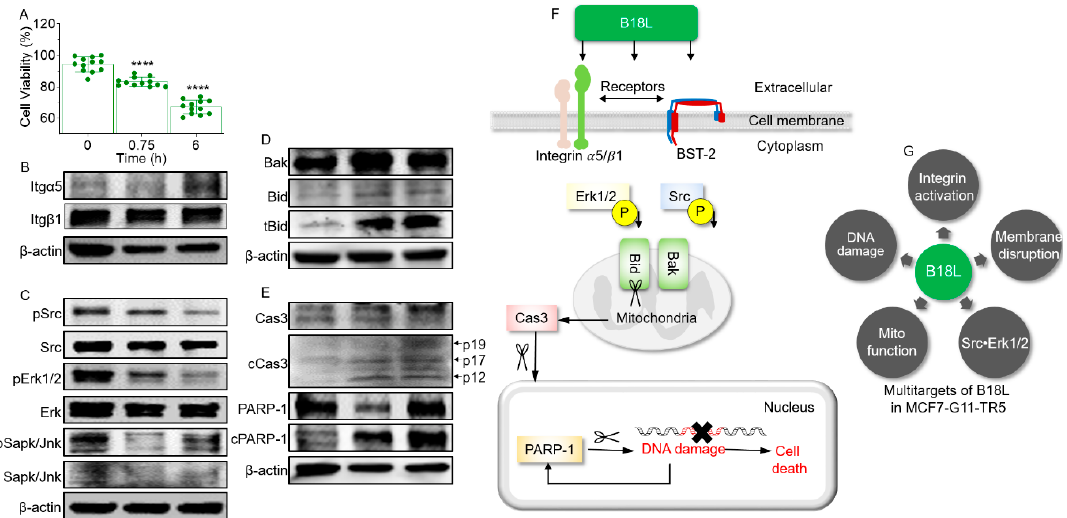
Figure 8. Intracellular signaling events in cells following treatment with B18L: ( A ) Cell viability following treatment with Vehicle (VEH) or B18L at 0.75 h or 6 h. Ordinary one-way ANOVA test (Dunnett’s correction) was used to determine the differences between the treated groups as compared to pre-treatment. **** p < 0.001. Western blot analysis of the effect of B18L on protein levels of ( B ) Integrins, ( C ) kinases, ( D ) BH3-only member of Bcl2 family of proteins, ( E ) Cas3 and PARP-1. β -actin was used as loading control. All replicate blots and original membranes are shown in Figures S12–S15. Densitometry readings / intensity ratio are in Table S3. ( F ) Cartoon of signaling molecules regulated by B18L. ( G ) Schematic of the multi-target e ff ects of B18L on MCF7-G11-TR5. Experiment was repeated at least three times, with similar